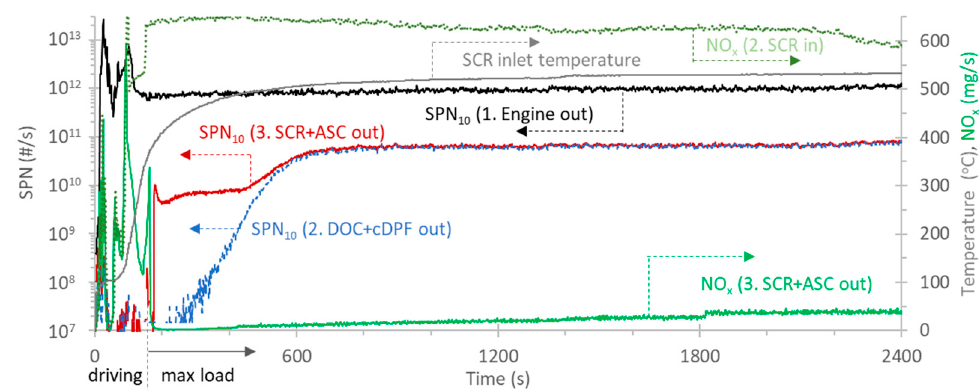
Figure 4. Maximum load test. The different colors represent different sampling locations. ASC = ammonia slip catalyst; DOC = Diesel oxidation catalyst; cDPF = catalyzed Diesel particulate filter; SCR = selective catalytic reduction; SPN = solid particle number.